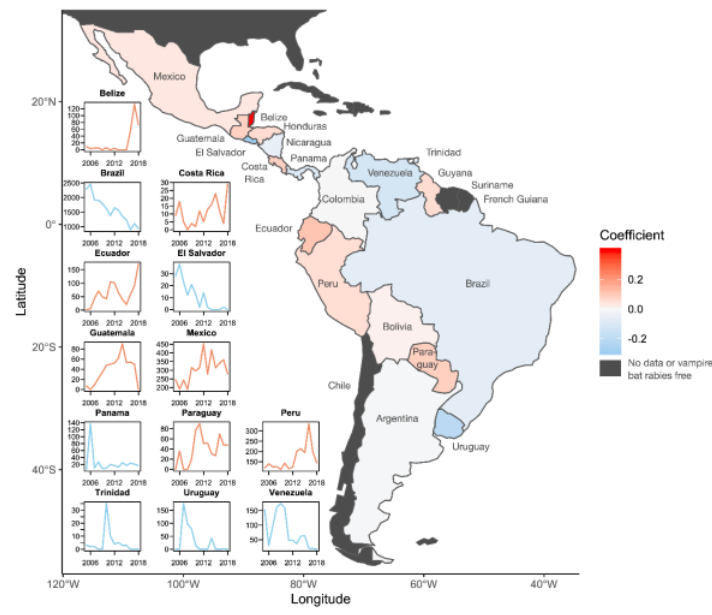
Figure 1. Geographic trends in rabies incidence across Latin America. Countries are colored according the coe ffi cient estimated from a Poisson-distributed generalized linear model relating year to the number of reported rabies cases in livestock ( N = 40287) and Desmodus rotundus ( N = 214). Reds indicate increases and blues indicate decreases in rabies from 2005 to 2018. The inset panels show time series for countries with statistically significant trends ( p < 0.05). Countries without DRRV or where data were unavailable are colored in dark grey. Data from the World Organization for Animal Health (OIE).